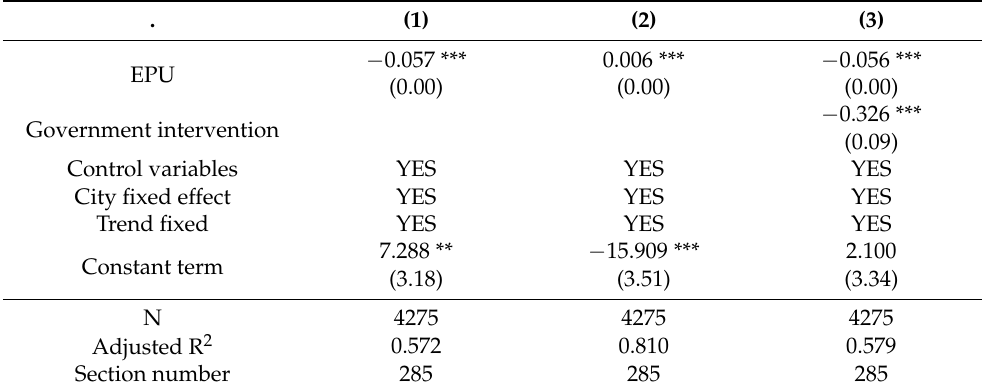
Table 7. Government intervention